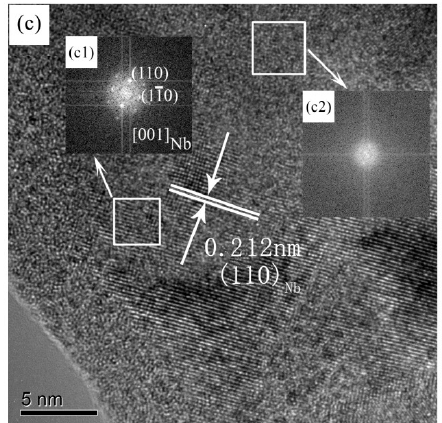
Figure 6. ( a ) BF-TEM image; ( b ) corresponding SAED image; ( c ) HRTEM image, ( c1 , c2 ) FFT pattern in different regions of the HRTEM image for the powder particles after ball milling for 20 h at 500 rpm. The BF-TEM, corresponding SAED and HRTEM images of the powders after ball milling for 40